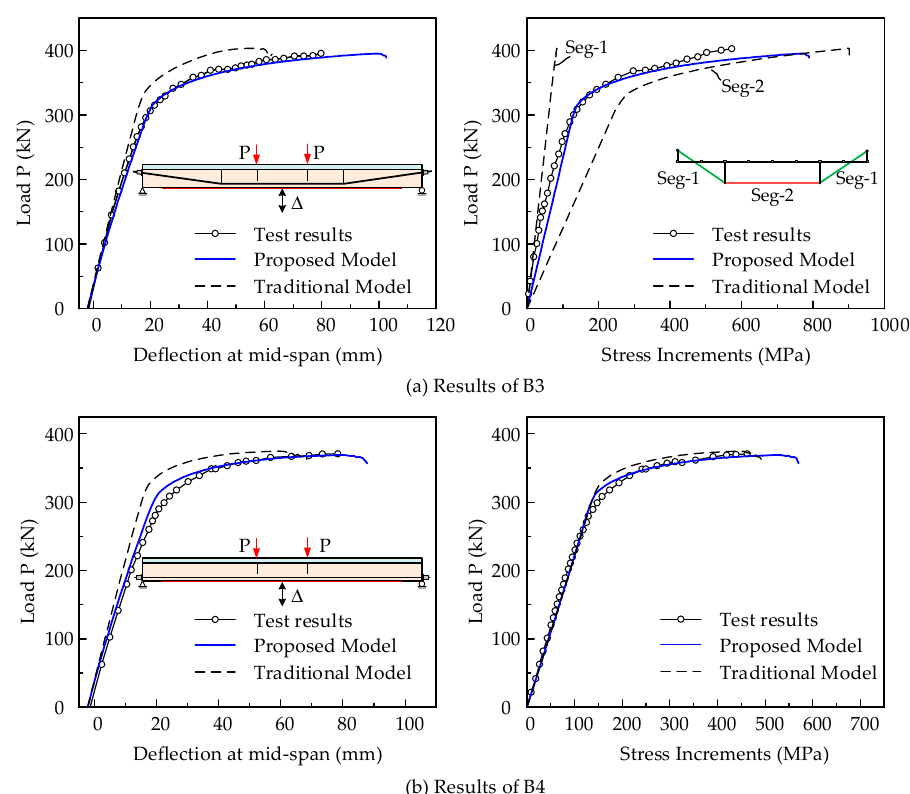
Figure 14. Analysis results of specimens B3 and B4.